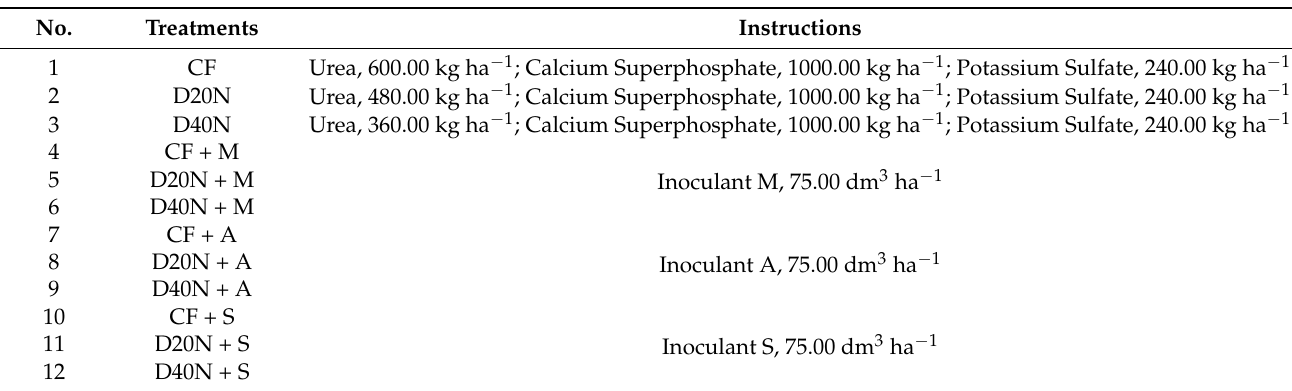
Table 1. All treatments and instructions of the field experiment.